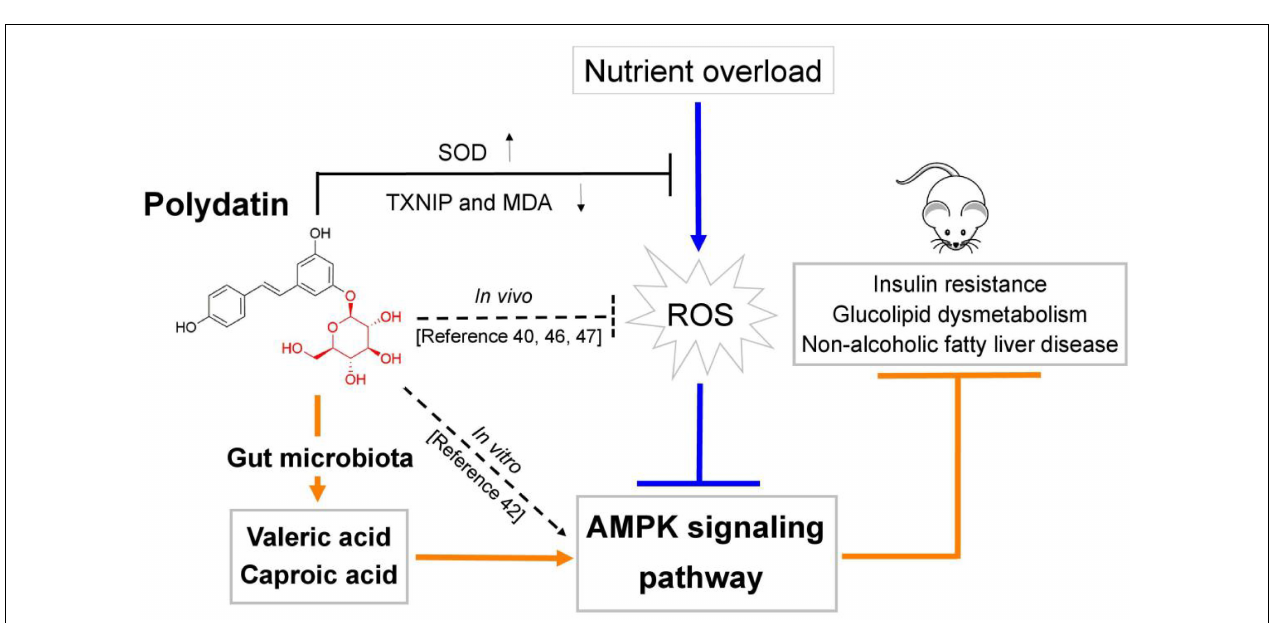
FIGURE 7 | Effects of valeric acid and caproic acid on p-AMPK α (Thr172) and p-ACC (Ser79) proteins and GPR41 and GPR43 mRNA levels in liver. (A) The protein levels of p-AMPK α (Thr172) and p-ACC (Ser79). (B,C) The mRNA levels of GPR41 and GPR43. Data are presented as mean ± SEM. ** p < 0.01, compared to control group. # p < 0.05, ## p < 0.01, compared to model group. ˆ p < 0.05, compared to control group. NS, p > 0.05.